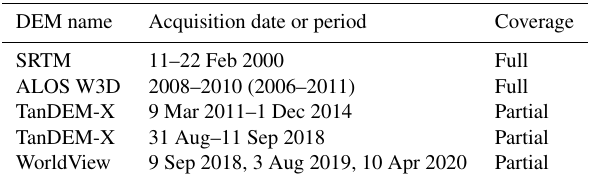
Table 2. List of available and generated